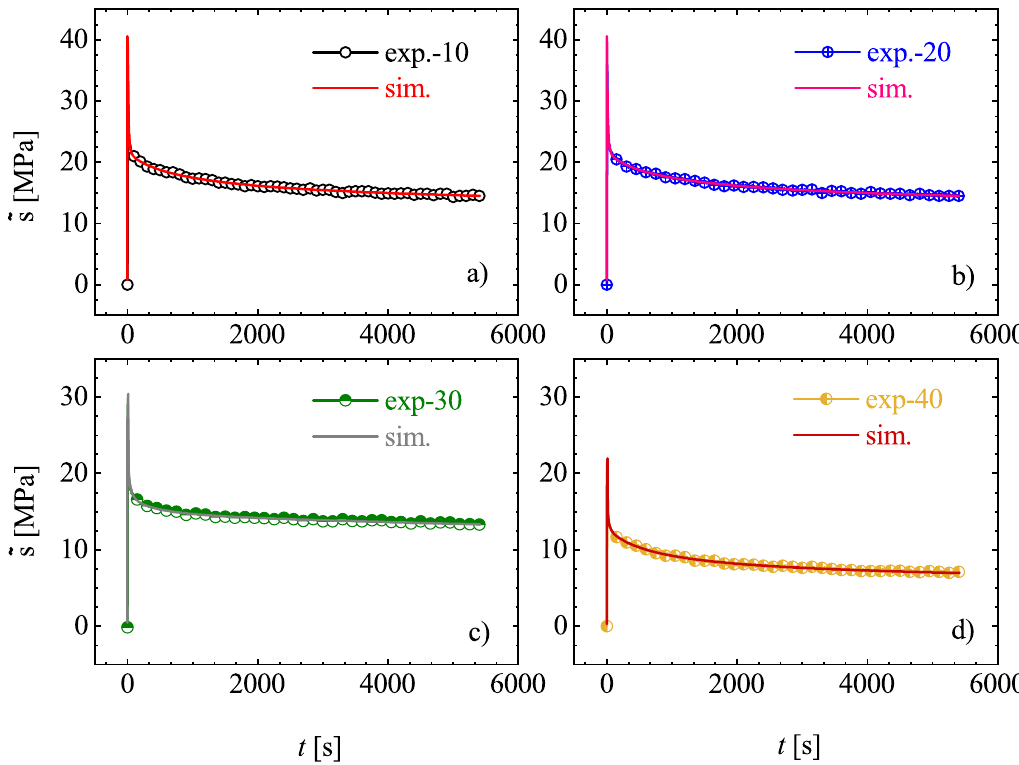
Figure 10. ( a – d ): Comparison of computational and experimental stress relaxation tests with different isothermal tempera- tures under θ g